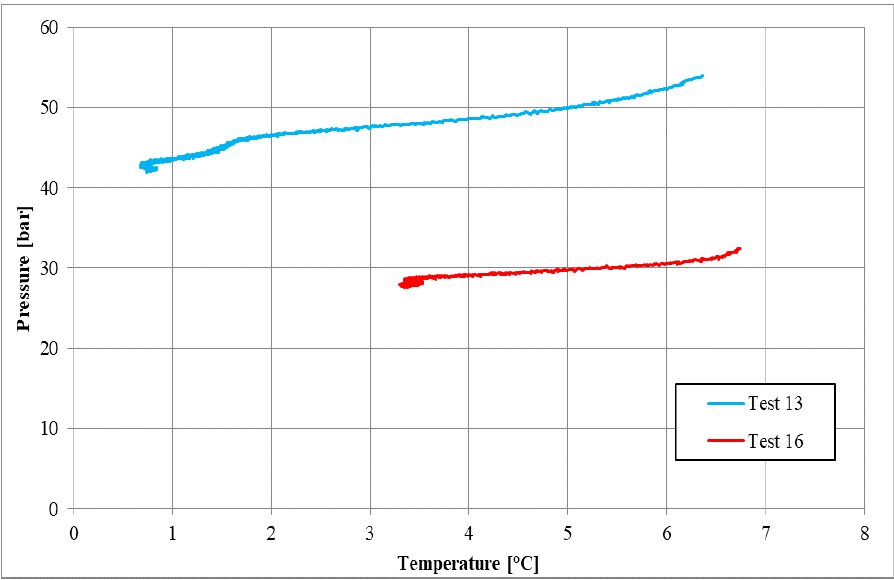
Figure 10. Comparison between Test 13, carried out using CH 4 , and Test 16, performed with CO 2 .